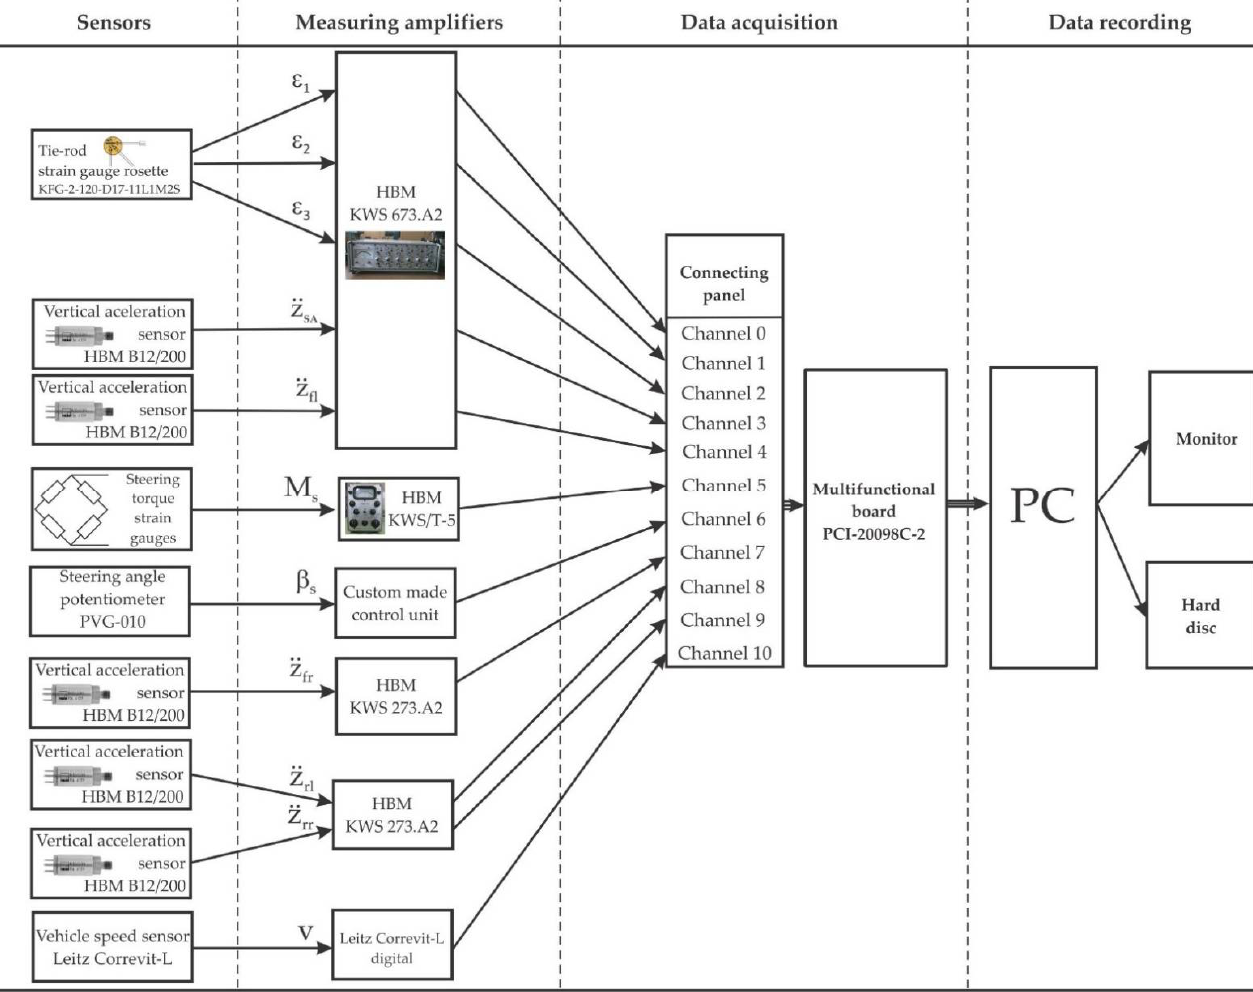
Figure 1. Experimental system.